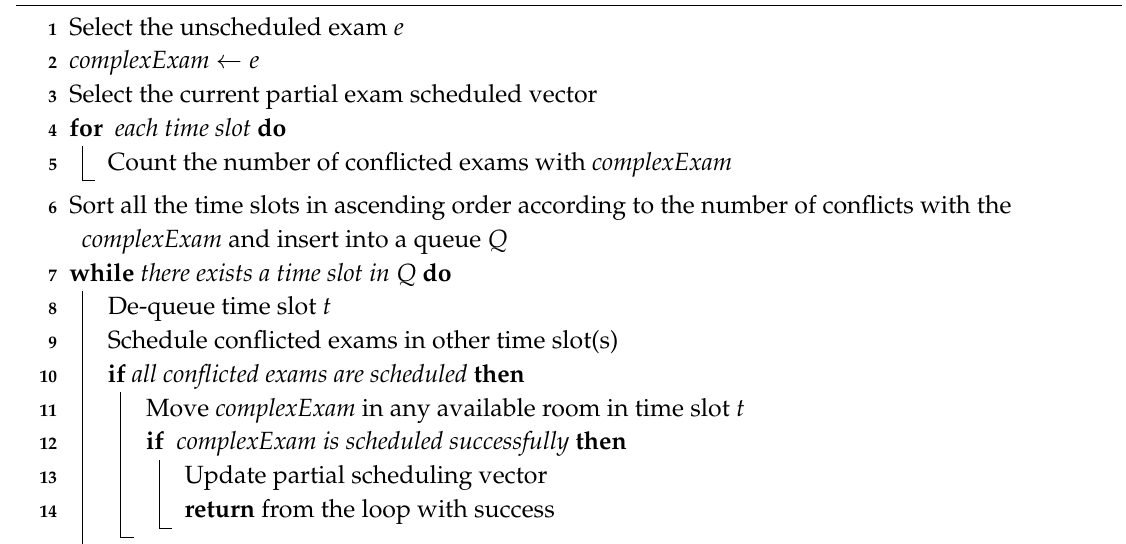
Algorithm 4: ExamResolutionManager